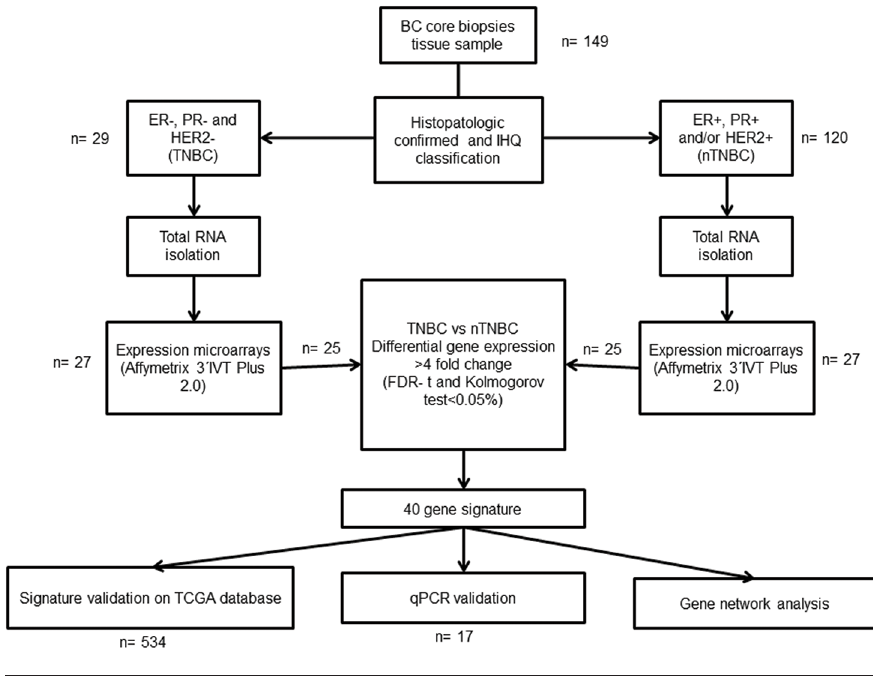
Figure 1. Study design. This diagram shows sampling and workflow of experiments and analysis of multiple comparison correction using the false discovery rate (FDR) method (23).